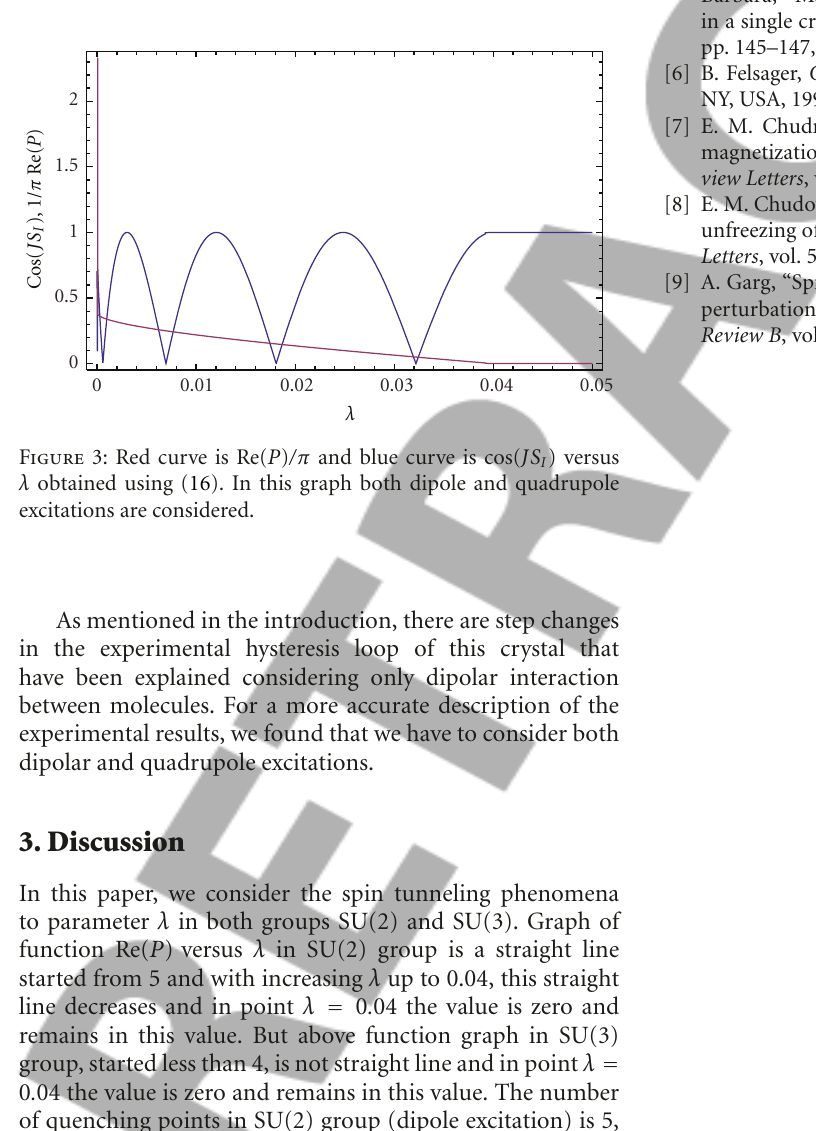
Figure 2: Red curve is Re( P ) /π and blue curve is cos( JS I ) versus λ obtained by using (11). In this graph, only dipole excitation was considered.